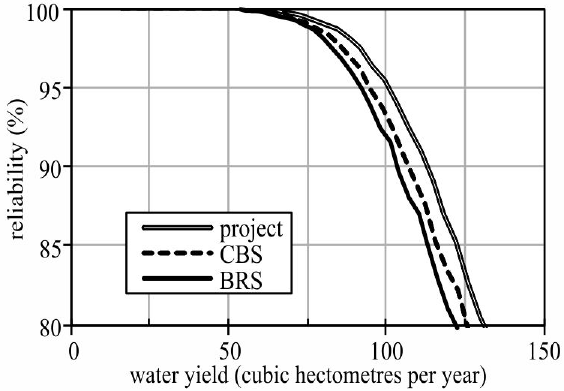
Figure 10. Water yield (availability) versus annual reliability for the Pentecoste reservoir as a function of the morphology (elevation-area-volume curves). Project—original curves; CBS—Conventional bathymetric survey; BRS—Bathymetric survey using Remote Sensing simplified